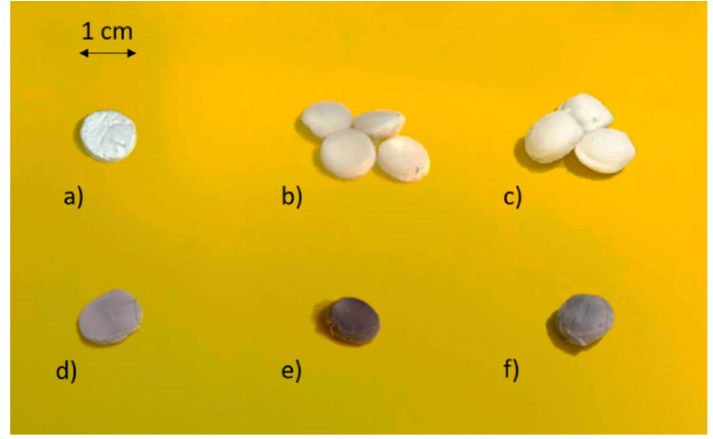
Figure 5. Non-impregnated and impregnated aerogels: ( a ) Alginate aerogels, ( b ) chitosan aerogels, ( c ) alginate aerogels coated with chitosan, ( d ) impregnated alginate aerogels, ( e ) impregnated chitosan aerogels, and ( f ) impregnated alginate aerogels coated with chitosan.